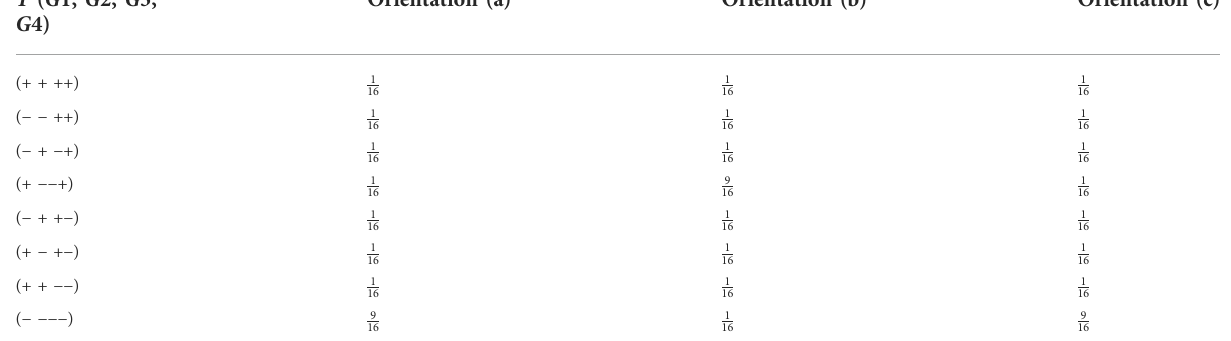
TABLE 2 Different probabilities of plaquette excitation.